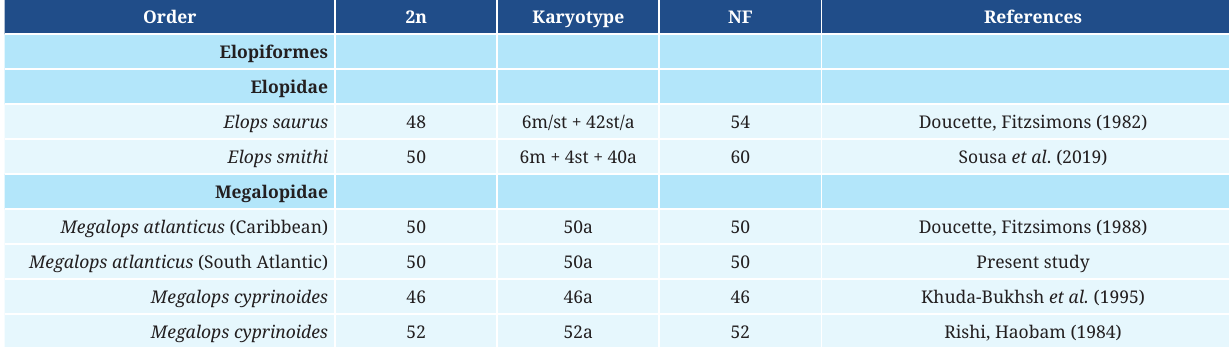
TABLE 1 | Cytogenetic data for species of Elopiformes